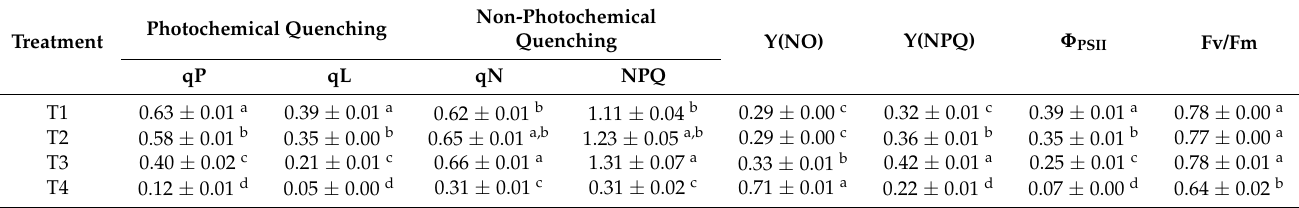
* Presented values are means ± SEs ( n = 18). a–d Different lowercase letters indicate statistically differences among treat ‐ ments ( p < 0.05).